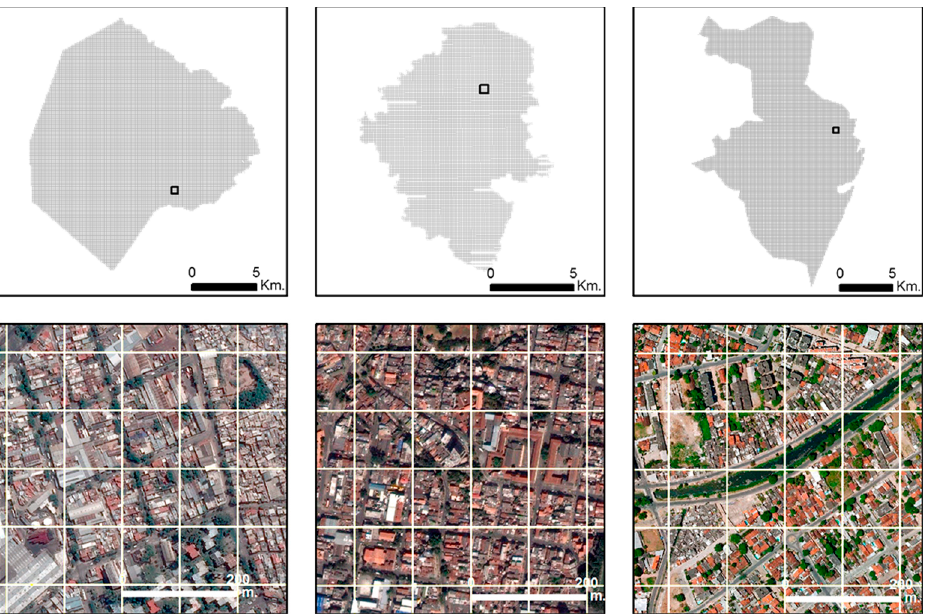
Figure 3. Urban areas and selected sectors showing the regular grid over the 2016 GE images of each city. From left to right: Buenos Aires, Medellin, and Recife.